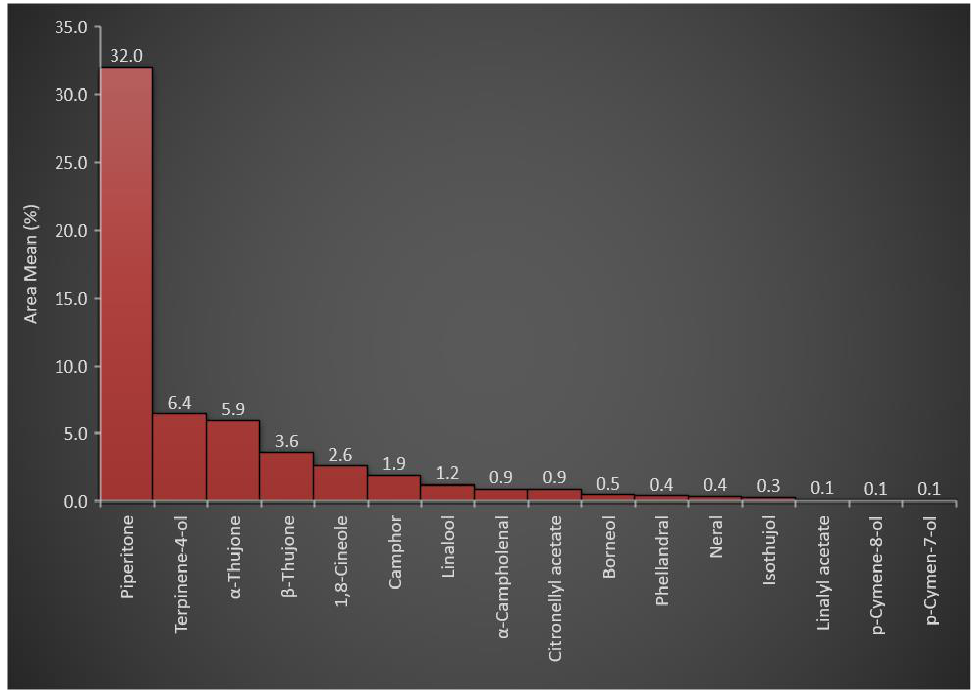
Figure 1. Representation of the oxygenated monoterpenes in A. judaica essential oil.